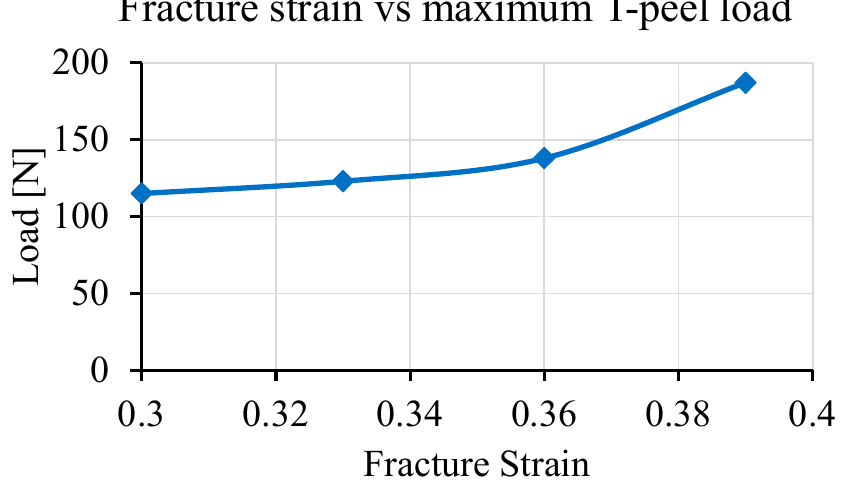
Figure 9. Impact of fracture strain on maximum T-peel load obtained by performing T-peel simula- tions.